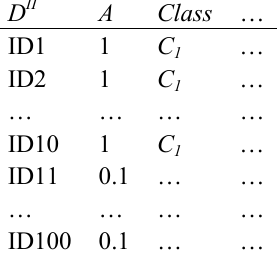
Table 8: Database D